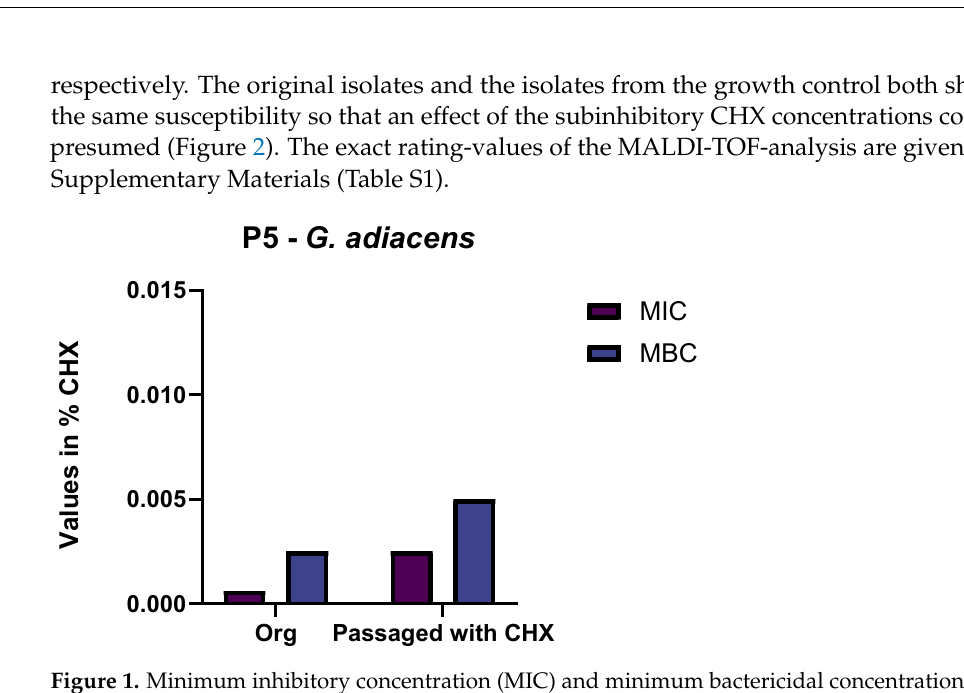
Figure 1. Minimum inhibitory concentration (MIC) and minimum bactericidal concentration (MBC) of G. adiacens isolated before (Org) and after passaging, with and without the addition of chlorhexidine (CHX). Values are depicted in percent of CHX. P5: Proband 5.